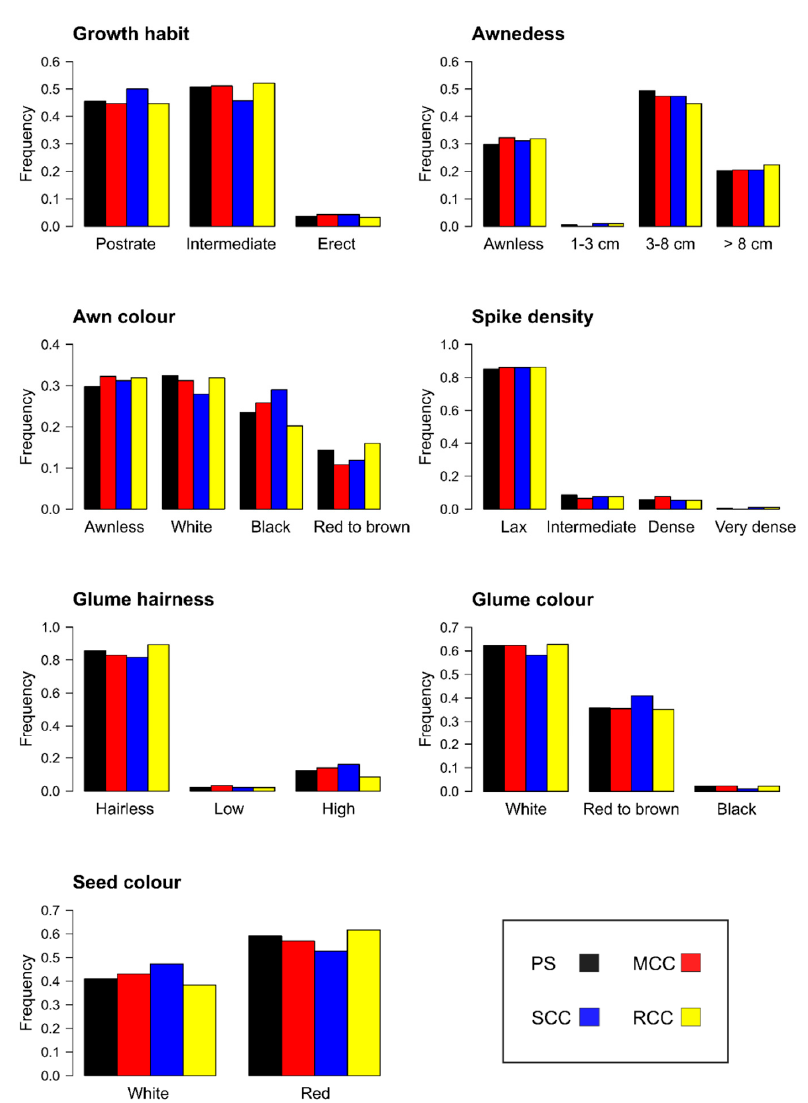
Figure 1. Relative frequencies of qualitative agromorphological traits in the primary set (PS) and core collections generated with the maximization strategy (MCC), stratified sampling (SCC) and random sampling (RCC).